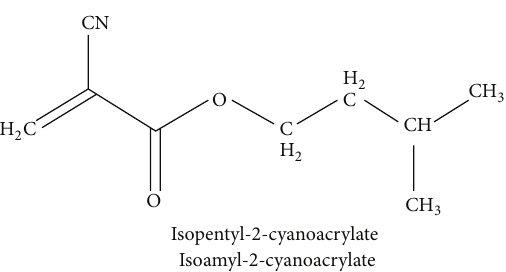
Scheme 1: Structure of